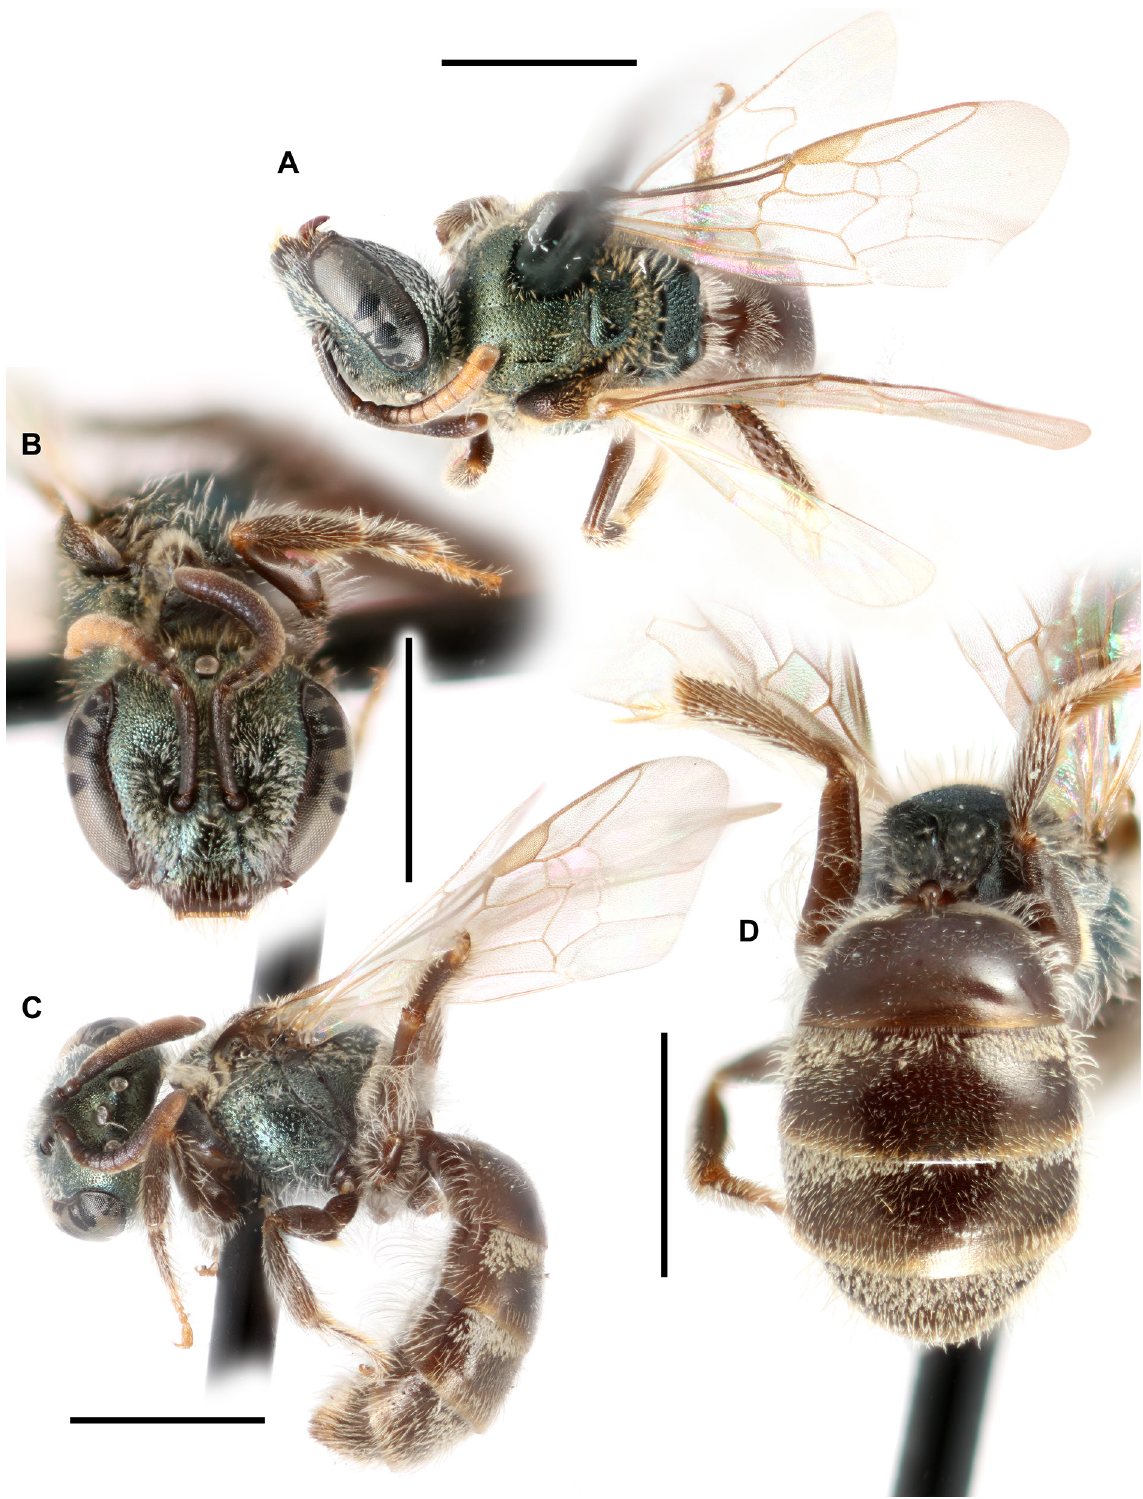
Fig. 63. Lasioglossum ( D .) stictaspis (Sandhouse, 1923), ♀, Mexico morph (WRME). A . Dorsal habitus. B . Face. C . Lateral habitus. D . Metasoma. Scale bars = 1